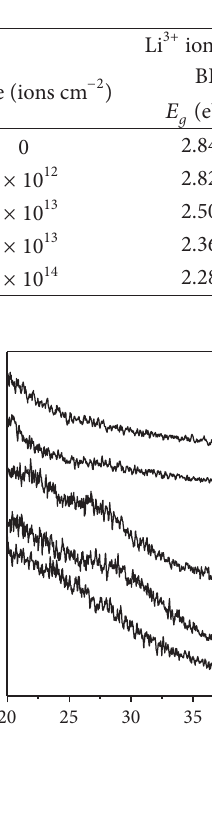
F 1: e X-ray diffraction patterns of the Ag